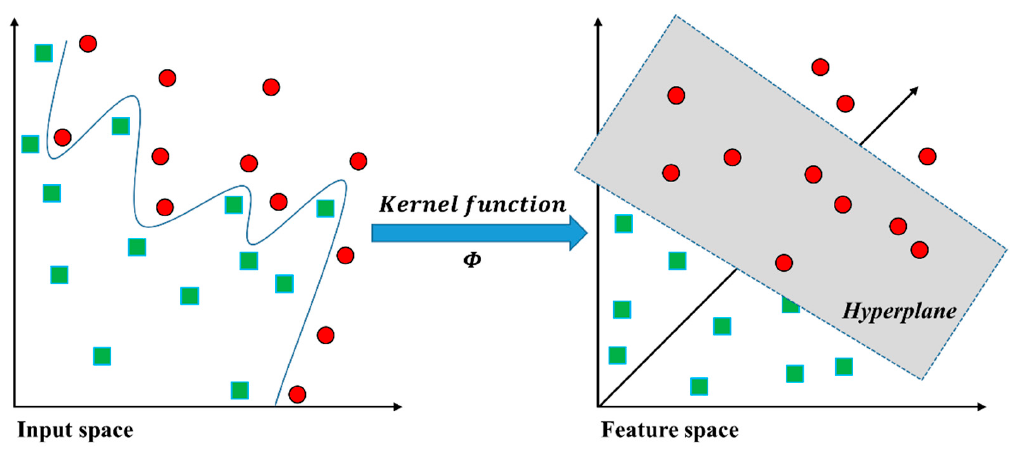
Figure 5. Graphical view of the SVM in the non-linearly separable case [25].